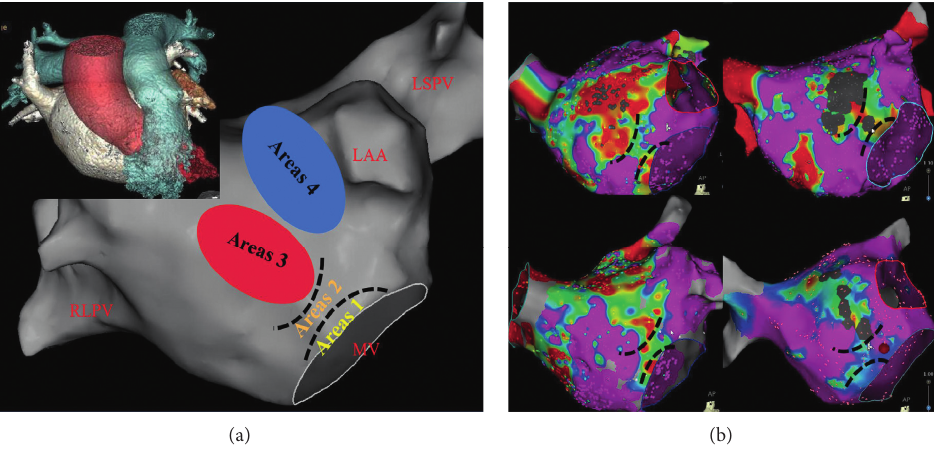
Figure 4: Subsegmentation of the low-voltage area on the left atrial anterior wall. (a) Area 1 was near the anterior MV at 11-12 o’clock; area 2 is the critical isthmus; area 3 was located at the mid anterior level of the left atrial anterior wall (LAAW); area 4 was located at the anterior top of the left atrium (LA) near the basal of left atrial appendage (LAA). (Top left illustration) the three-dimensional (3D) enhanced cardiac computed tomography shows the anatomical relationship between the LA, aorta, and pulmonary artery. (b) Voltage maps show patients with different degrees of scarring have a critical isthmus (black dotted lines) between the scar of LAAW and the MV. LAA: left atrial appendage; MV: mitral valve; LSPV: left superior pulmonary vein; RSPV: right superior pulmonary